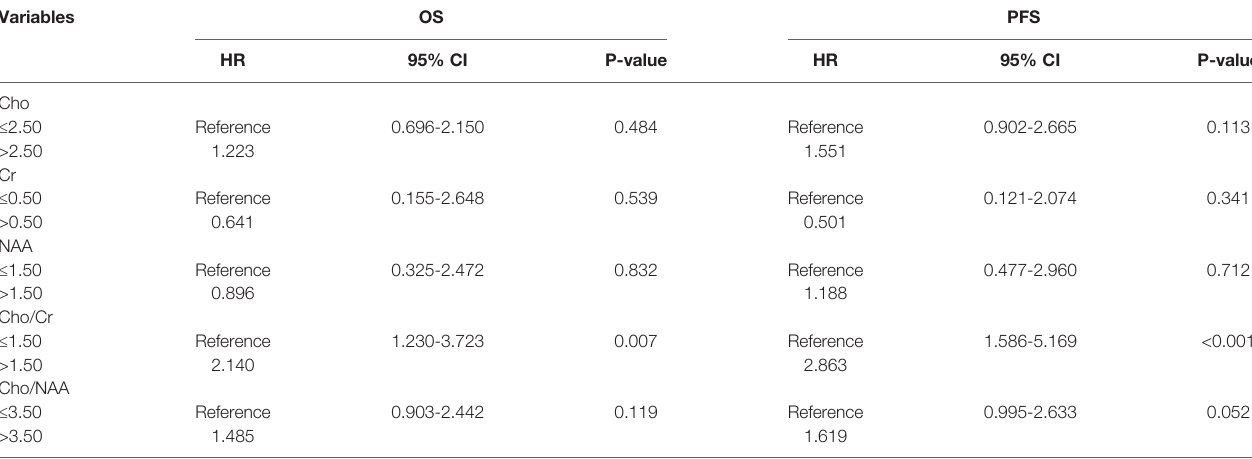
TABLE 4 | Univariate analysis of OS and PFS based on MRS metabolic characteristics and in fl ammation